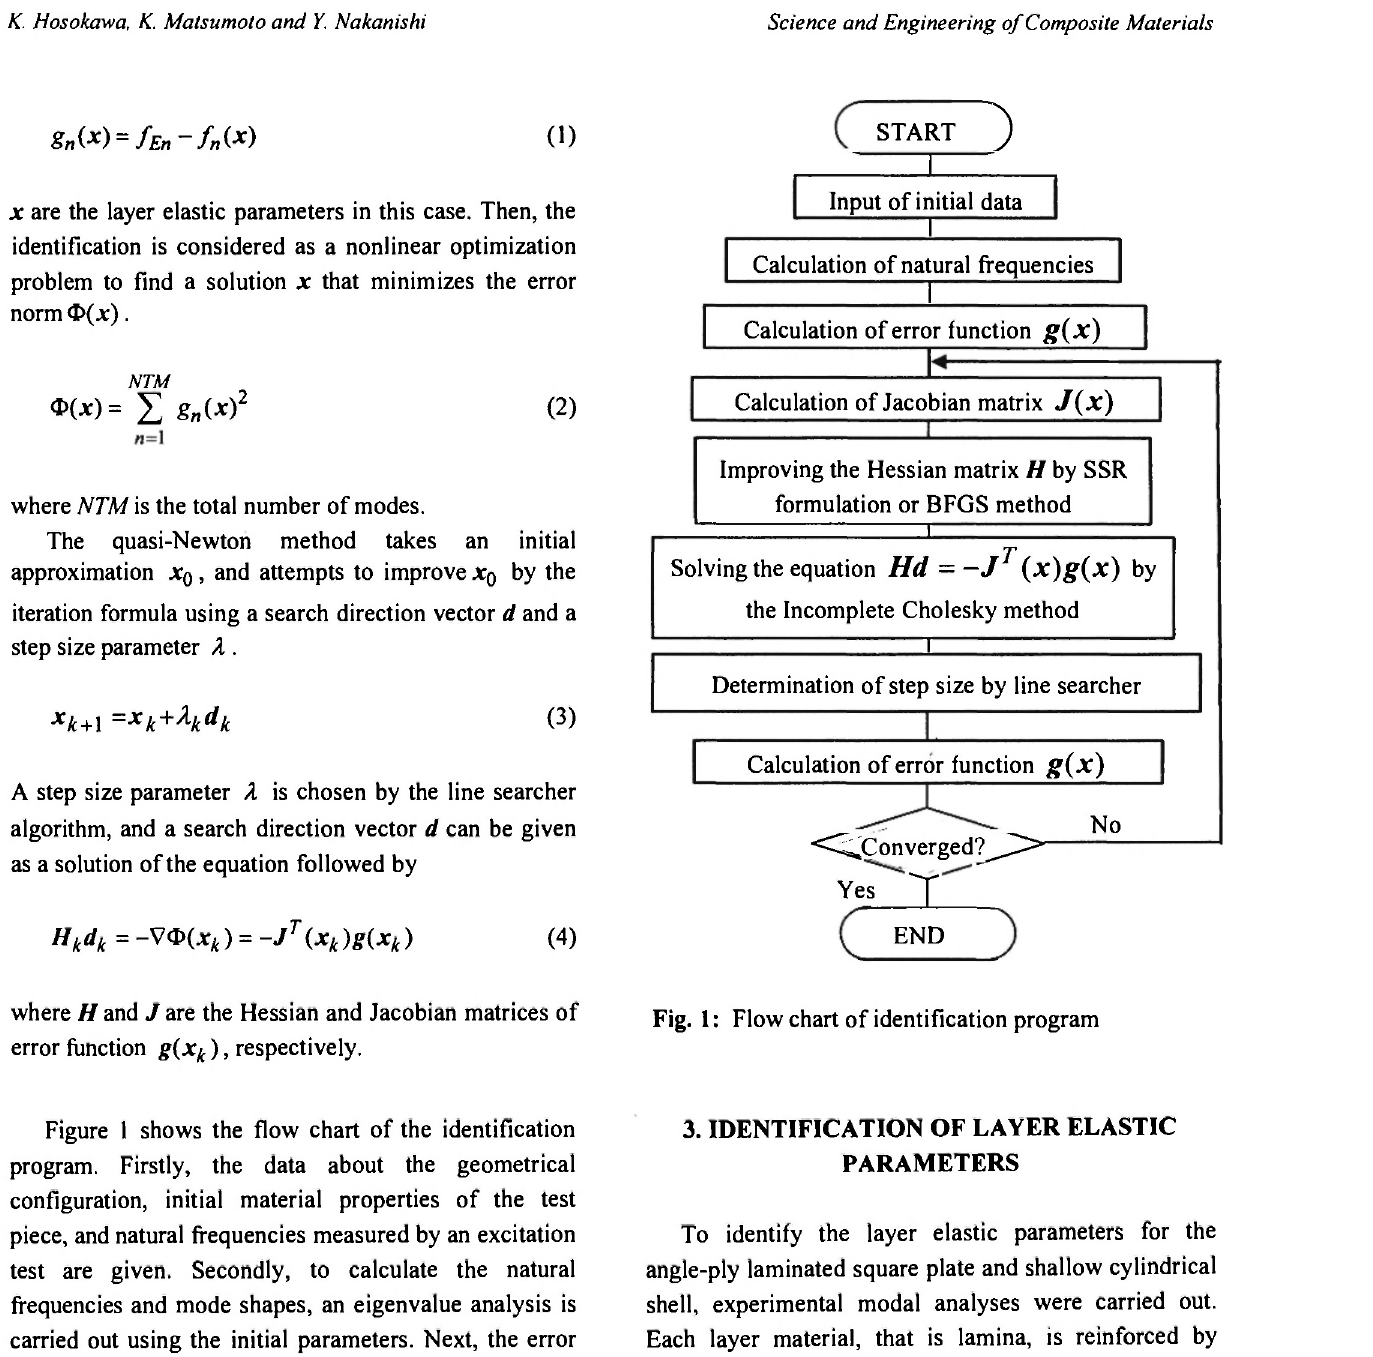
Fig. 1: Flow chart of identification